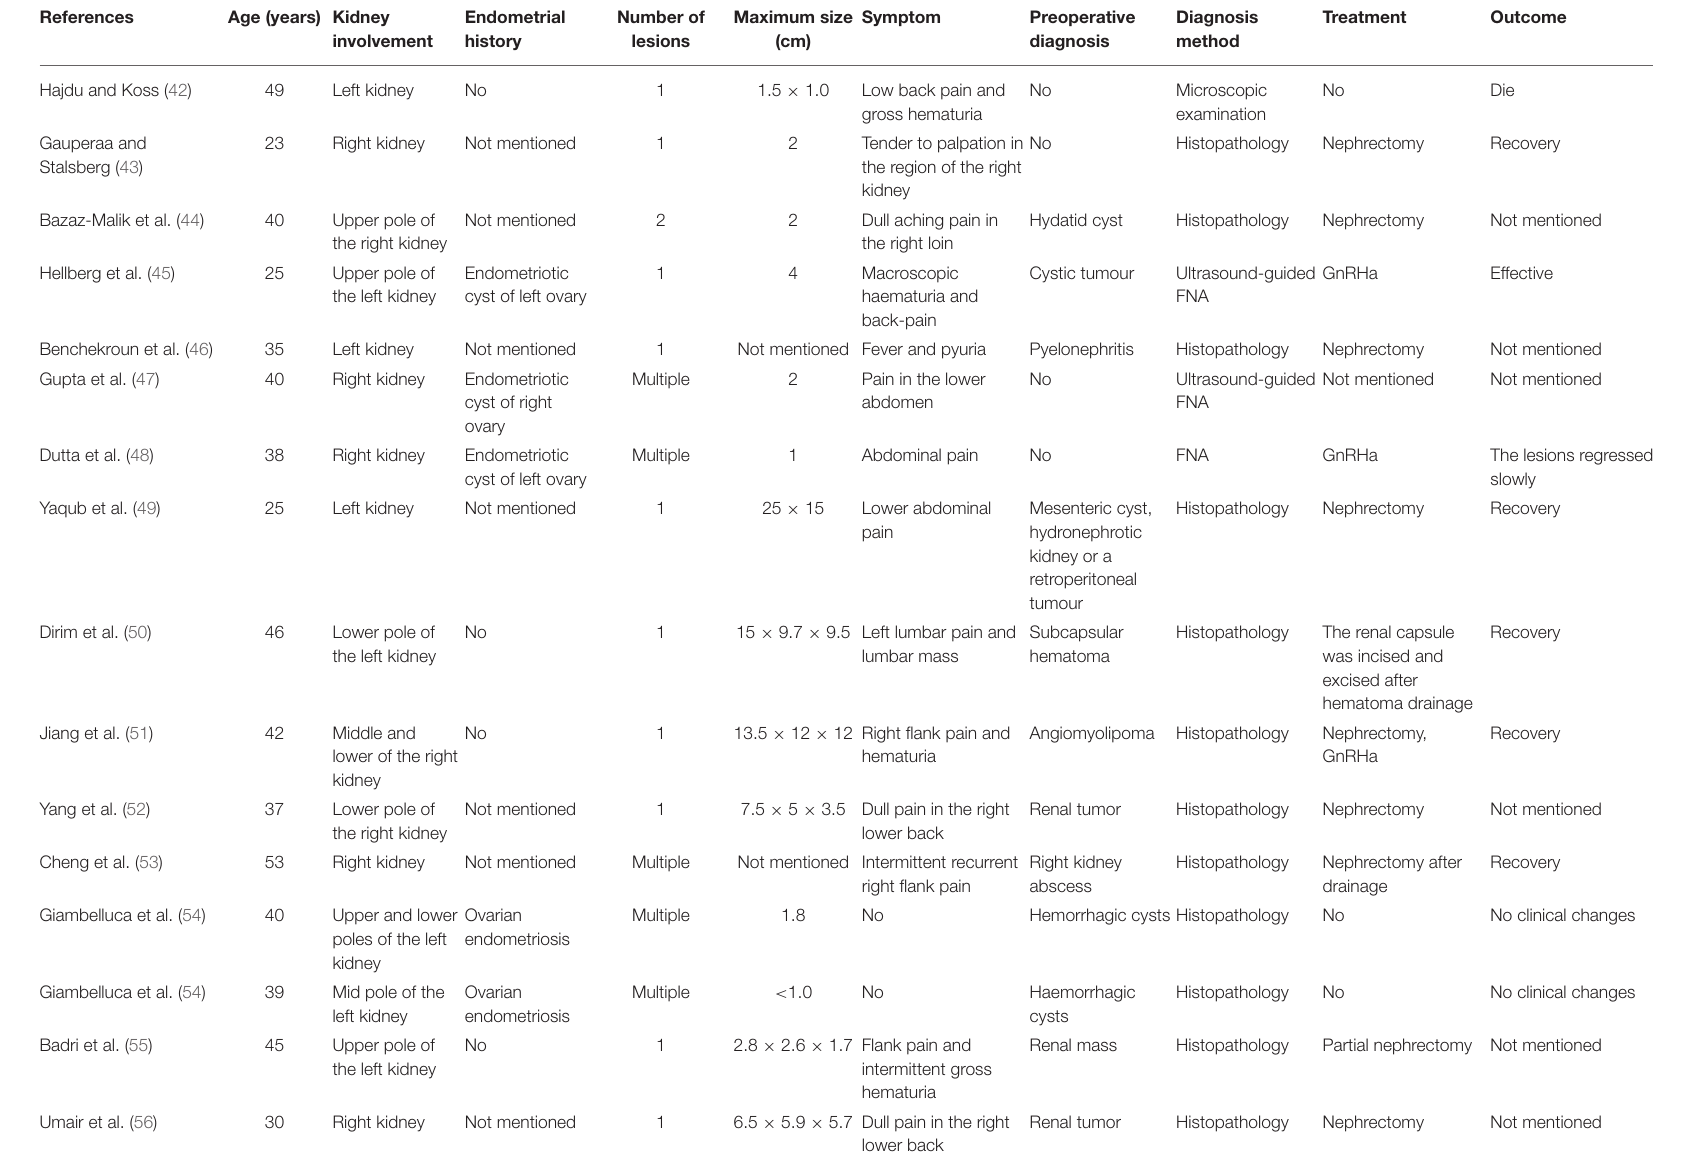
TABLE 2 | Case reports of renal